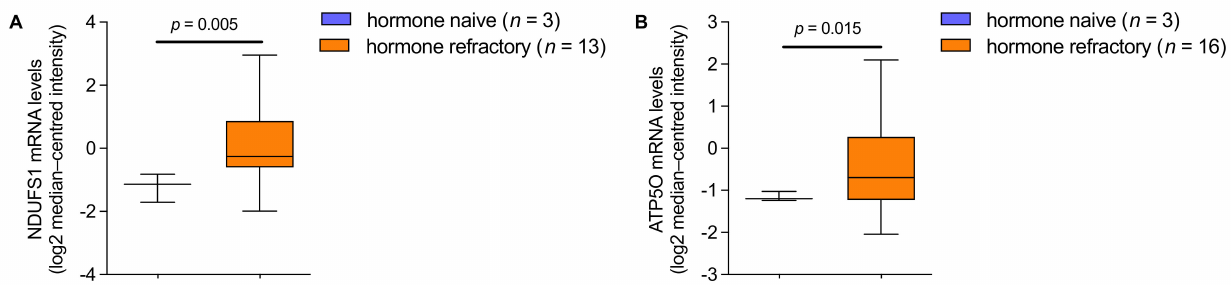
Figure A3. ( A ) NDUFS1 mRNA expression levels in prostate cancer patients, analyzed from hormone naive ( n = 3) and hormone refractory ( n = 13; 2.64-fold increase) tumors. ( B ) ATP5O mRNA expression levels in prostate cancer patients, analyzed from hormone naive ( n = 3) and hormone refractory ( n = 16; 1.56-fold increase) tumors. Data for ( A , B ) were extracted from the Oncomine™ Platform from the Tomlins Prostate dataset. Representation: boxes as interquartile range, horizontal line as the mean, whiskers as lower and upper